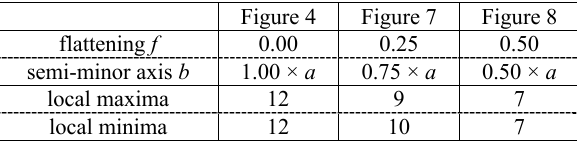
Table 2. Number of local maxima and local minima of the measurement accuracy by CM (12 pixels  a  18 pixels,  = 22.5º)